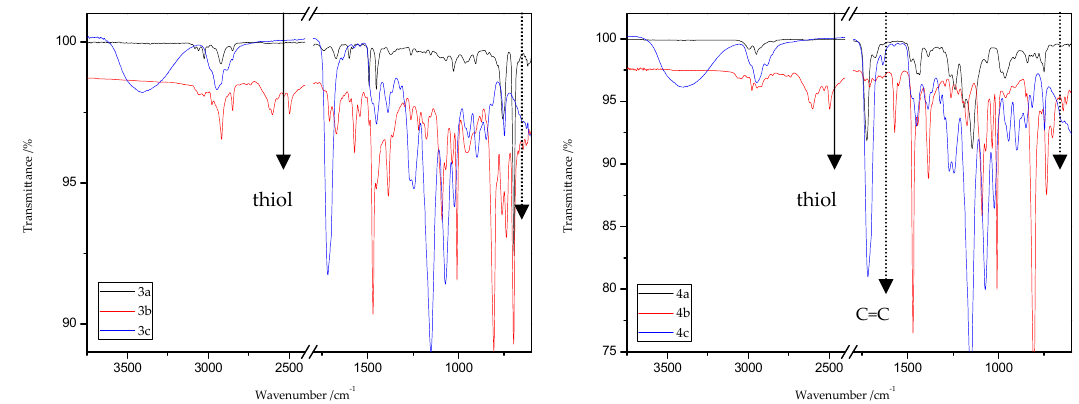
/ FT-IR spectra of ST (3a–c) and MMA (4a–c) Figure 15. ATR/FT-IR spectra of ST (3a–c) and MMA (4a–c) copolymers. Figure 15. ATR